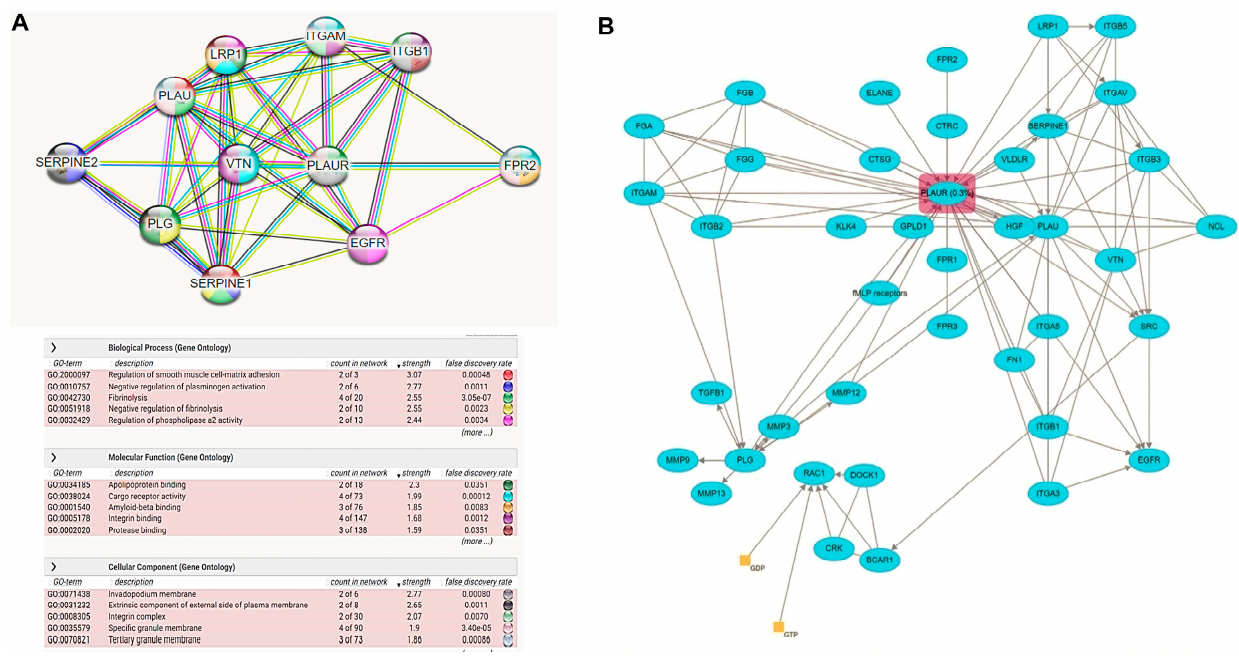
Figure 7. PLAUR pathway analysis: ( A ) The protein–protein interactions network with the top biological processes, molecular functions, and pathways created by the “STRING database”. Each interacting node with the hub PLAUR represents the top 10 predicted functional protein partners with a high confidence level. ( B ) Reactome database fibrinolysis pathway was modified to show how an infection could affect the fibrinolysis